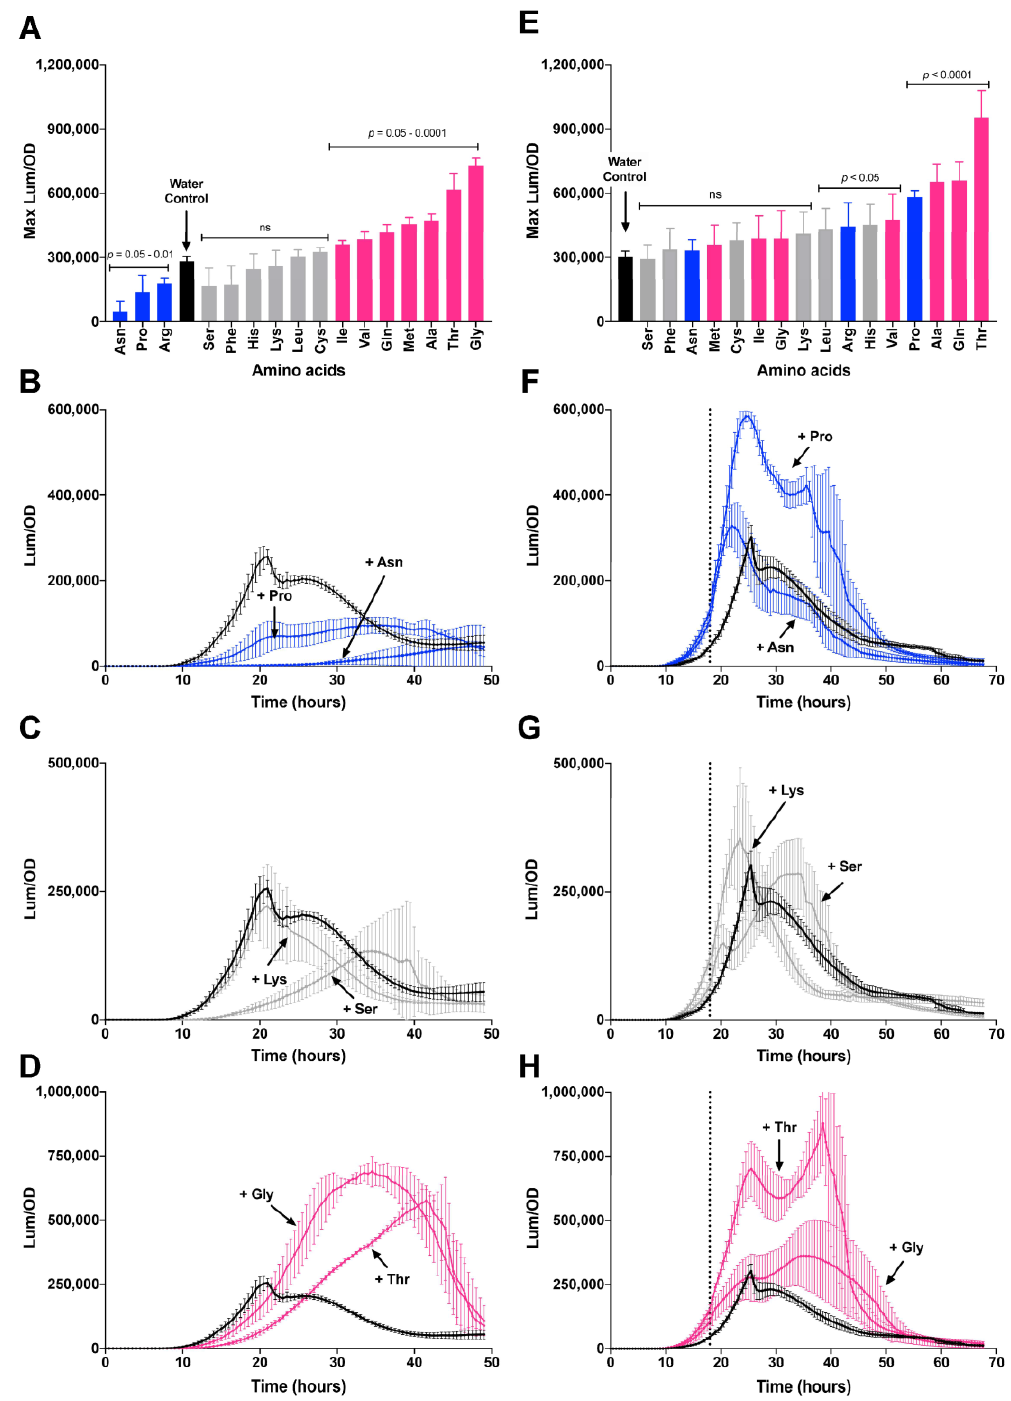
Figure 6. Individual amino acids have differing effects on the csgD biofilm regulatory network in S. Typhimurium 14028. Maximum expression of the csgBAC operon (curli production) was recorded during growth of S. Typhimurium 14028 at 28°C in media premixed with 15 mM of individual amino acids ( A ) or in media where the amino acids were added after 18 h of growth. The maximum Lum/OD values after addition of each amino acid were statistically compared to a water control and amino acids were determined to have a repressive (blue), neutral (grey) or stimulatory effect (purple) on csgB expression ( A ). This color scheme was used to represent the same amino acids when they were added after 18 h of growth ( E ). Lum/OD values were plotted as a function of time corresponding to selected amino acids premixed into the media ( B – D ) or added at 18 h of growth ( F – H ; the dotted line represents the time of addition). For each curve, the mean and standard deviations are plotted from three biological replicate experiments measured in